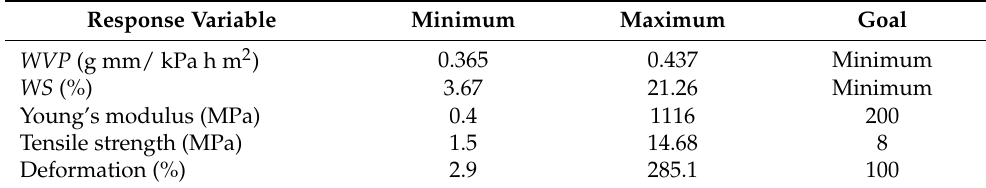
Table 3. Optimization